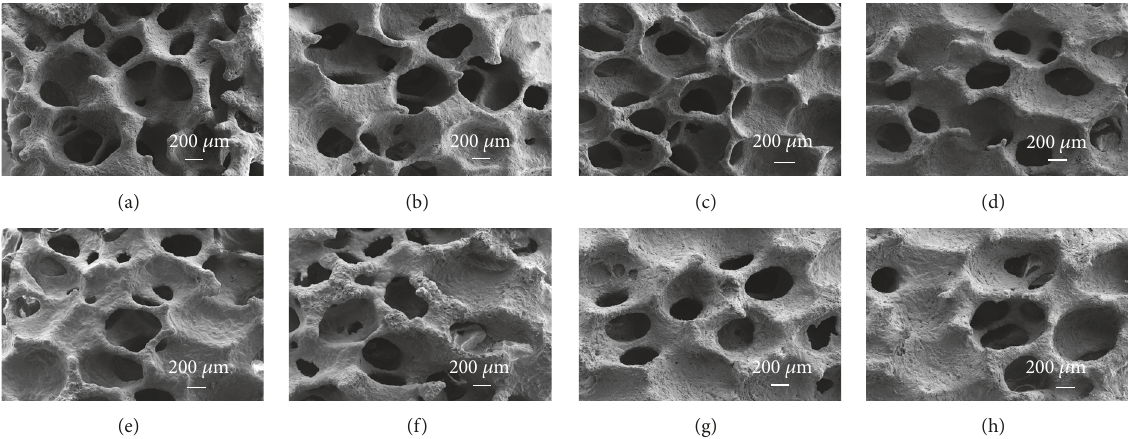
Figure 1: SEM morphologies of the 𝛽 -TCP porous scaffolds with different concentration and coating times: (a) 35TCP2, (b) 35TCP3, (c) 40TCP2, (d) 40TCP3, (e) 45TCP2, (f) 45TCP3, (g) 50TCP2, and (h) 50TCP3. In the abbreviation, the number in front signifies the concentration (w/v%) of 𝛽 -TCP powder included in slurry, and the number in back signifies the repetition number of immersion in slurry for fabrication of scaffold.